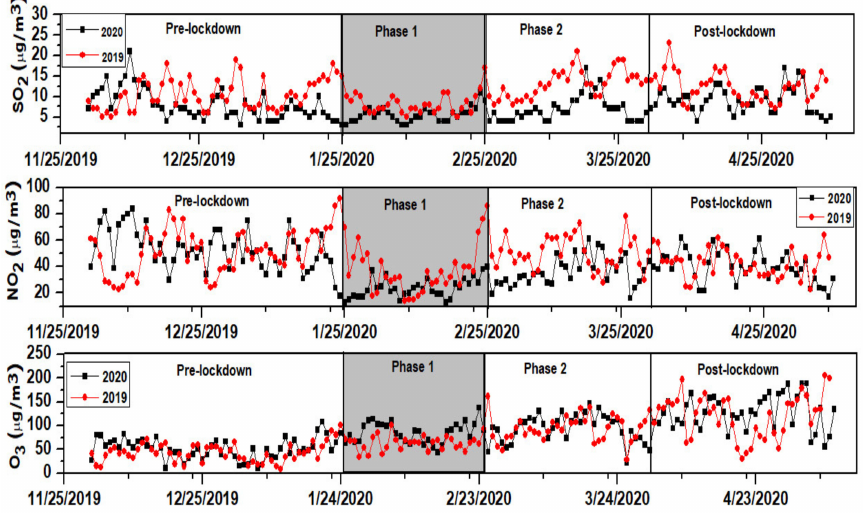
Figure 5. In-situ measurements of SO 2 , NO 2 , and O 3 during 2019 and